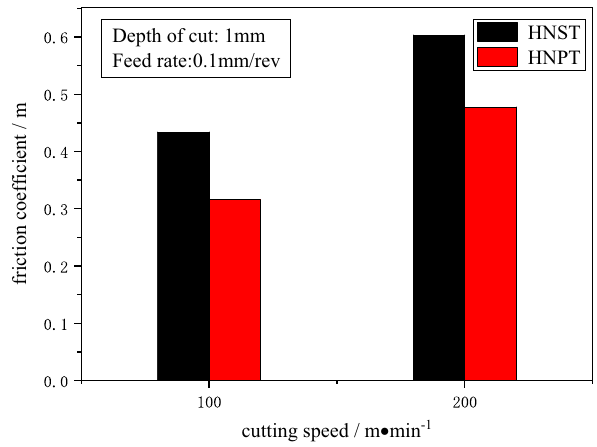
Figure 10: E ff ect of cutting speed on the tool – chip friction coe ffi cient.